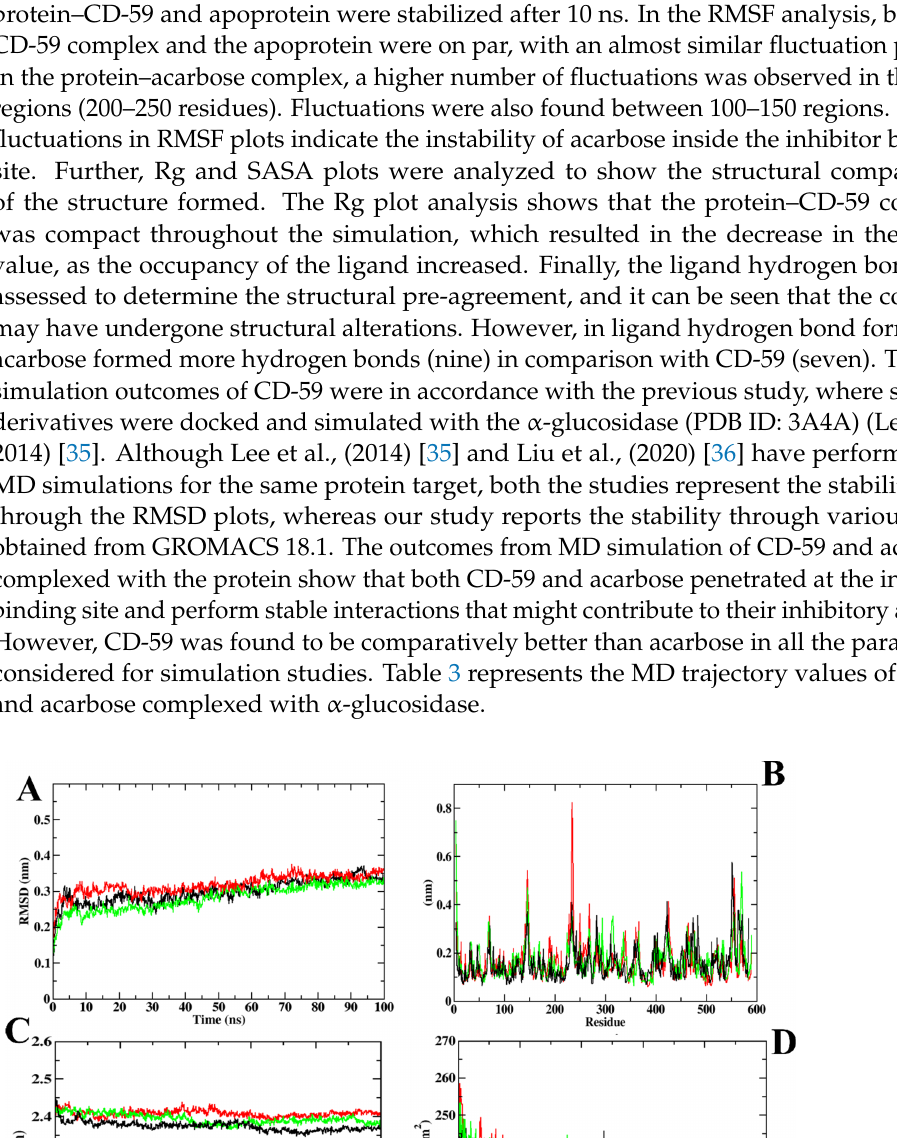
Table 3. MD trajectory values obtained for CD-59 and acarbose complexed with α -glucosidase.